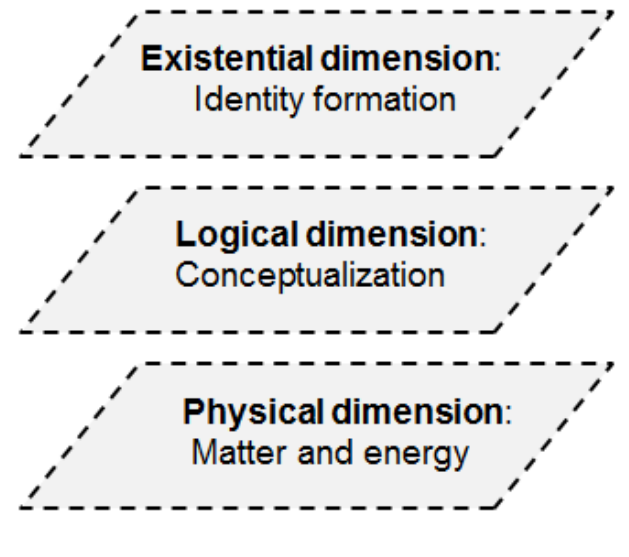
Fig. 2 . Territorial meta-model. Simplified version of the territorial meta-model developed by Schwarz (1992) and adapted by Maurel (2012). The model has its origins in cybernetics and describes the evolution of systems toward complexity and